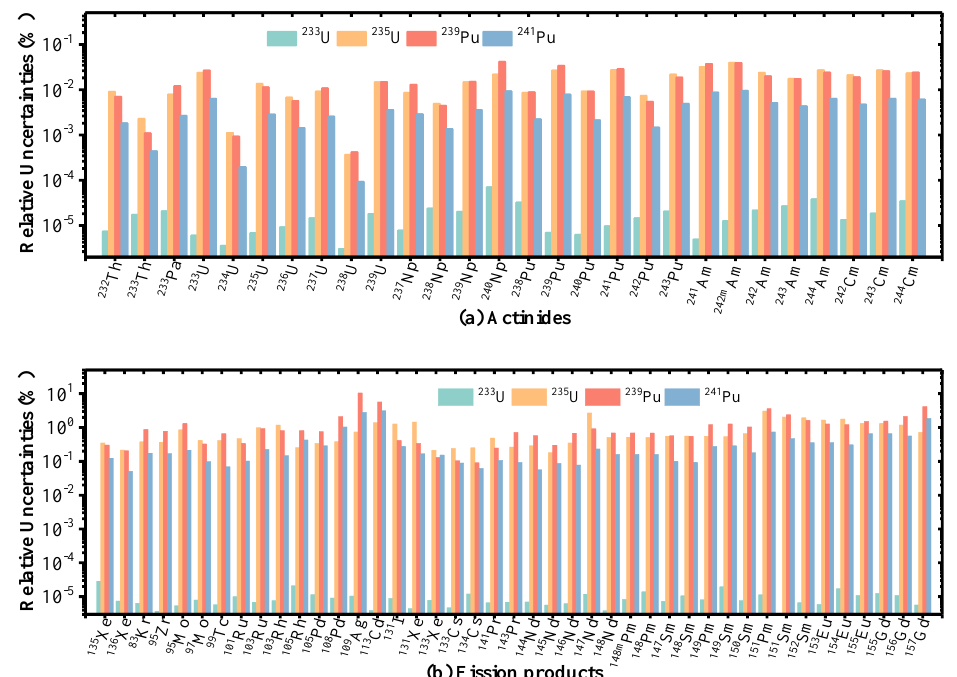
Figure 7. Nuclide density uncertainties of actinides and fission products from individual uncertainty analysis.